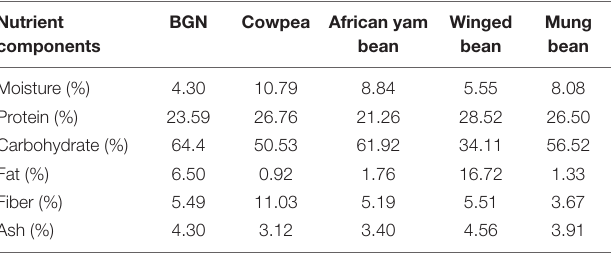
TABLE 1 | Nutritional components of BGN and some underutilized legumes. Nutrient